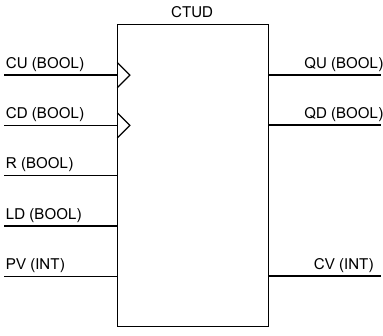
Figure 1. The symbol of CTUD